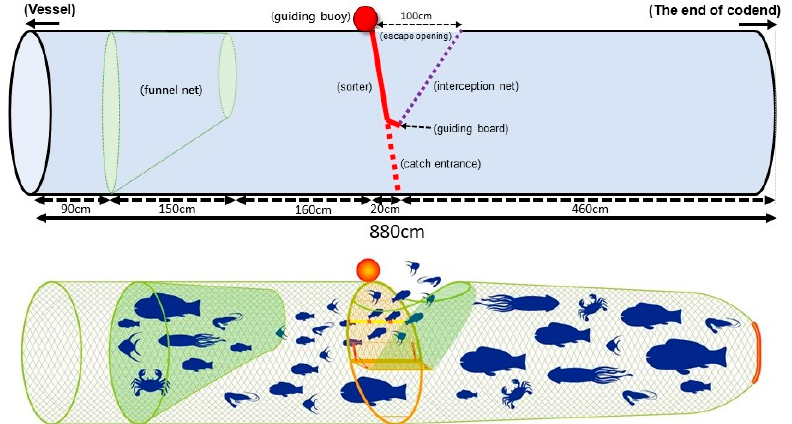
Figure 1. Side view of developed JTED for Taiwanese bottom trawlers with single boat bottom otter trawls.